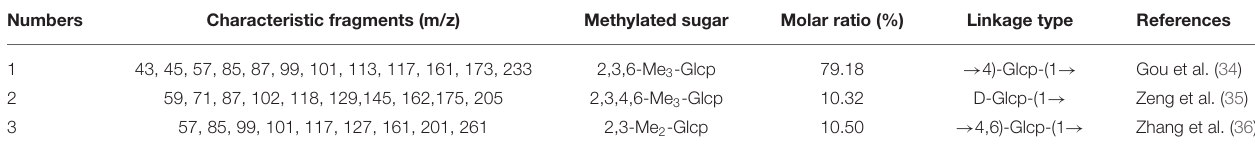
TABLE 1 | Glycosyl linkages analysis of PSP-1.